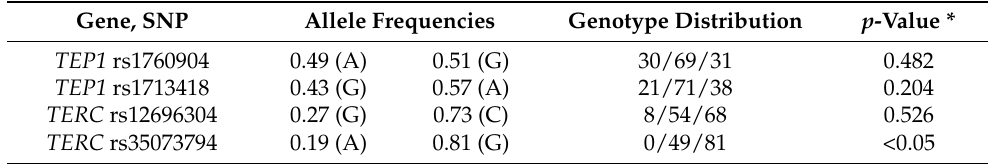
Table 2. Hardy-Weinberg equilibrium analysis. Gene, SNP Allele Frequencies